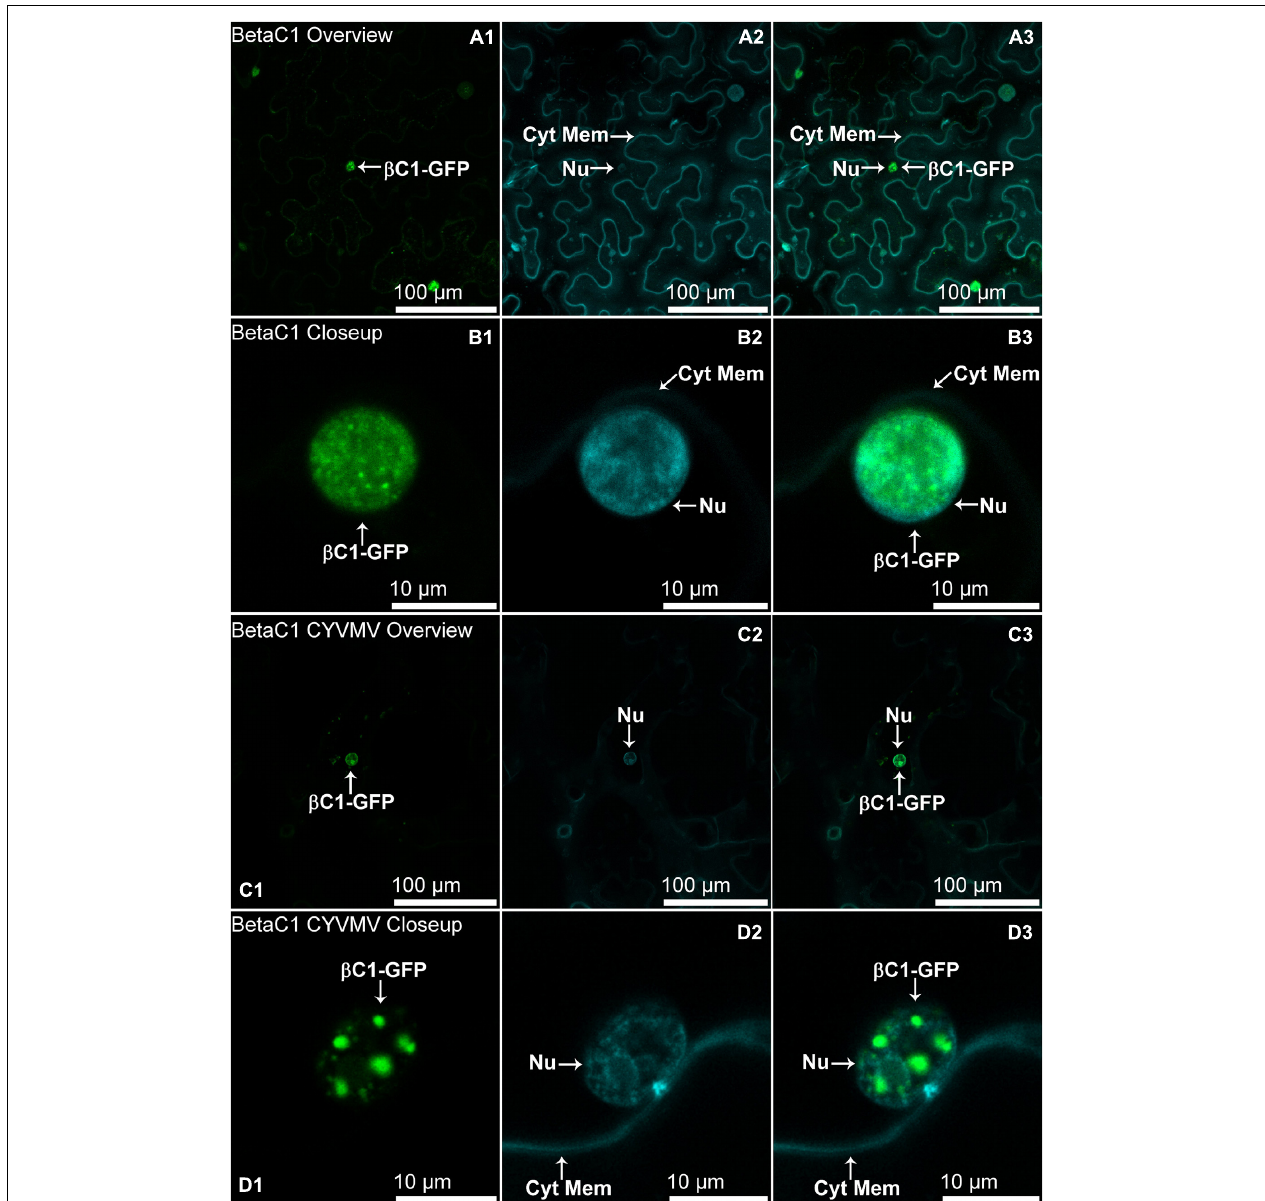
FIGURE 6 | Subcellular localizations of CroYVMB, β C1-GFP in N. benthamiana leaves under stand-alone (A,B) and CYVMV-inoculated (C,D) conditions. Panels (A,C) were taken under lower zoom, while panels (B,D) were taken with higher zoom. Images showing GFP fluorescence (A1,B1,C1,D1) , and Hoechst fluorescence (A2,B2,C2,D2) . Merged images of both GFP and Hoechst fluorescence were shown as panels (A3,B3,C3,D3) . Both β C1-GFP and β C1-GFP + CYVMV showed strong GFP fluorescent signal in the nucleus. Arrowheads indicate the locations of β C1-GFP and major sub-cellular organelle (Nu: nucleus; Cyt Mem, cytoplasmic